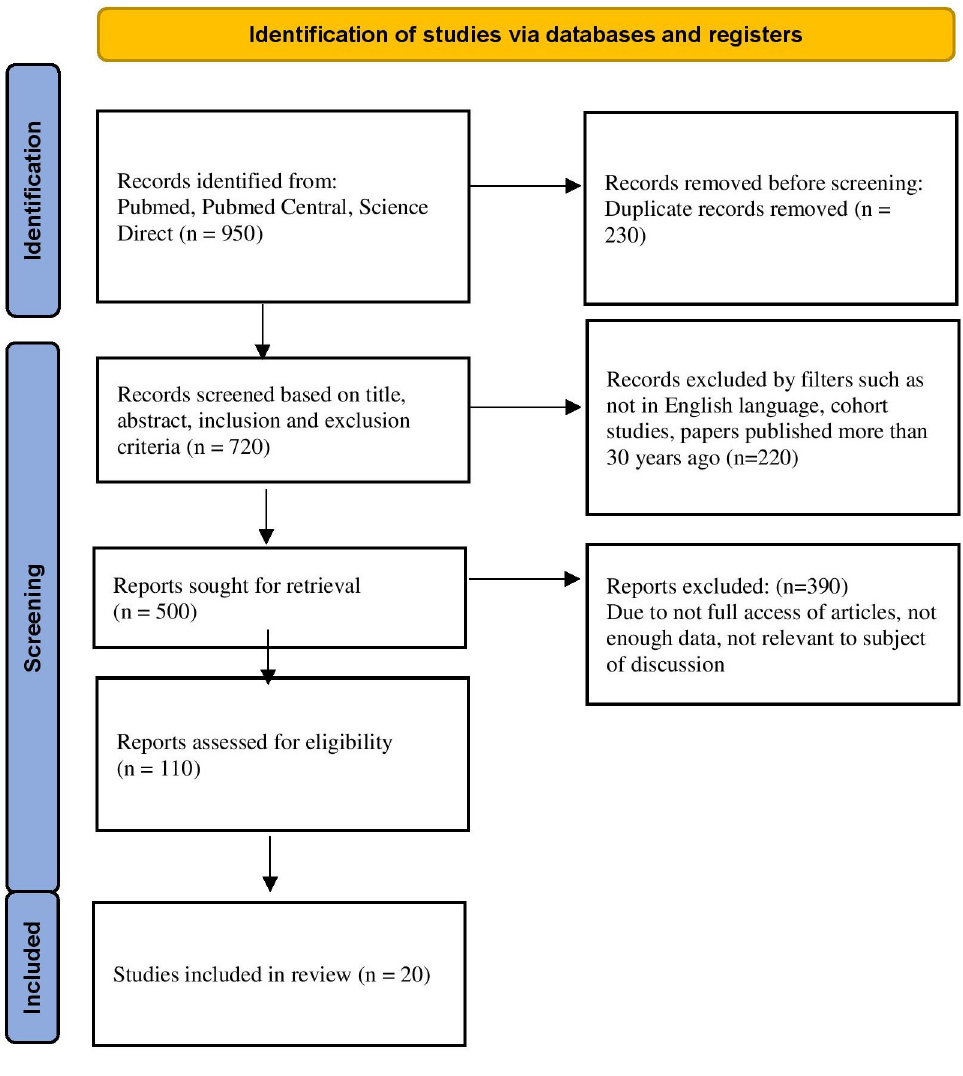
Figure 1. Prisma Flow Diagram.